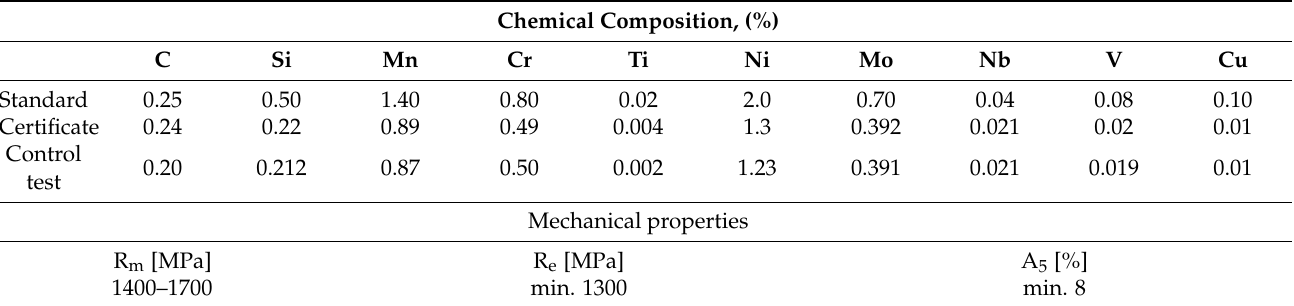
Table 1. Chemical composition and mechanical properties of steel grade S1300QL. Chemical Composition, (%)